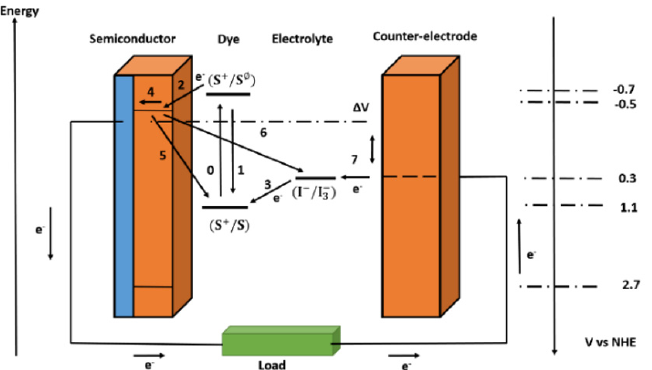
Figure 2. Simple energy level diagram for a DSSC. The basic electron transfer processes are indicated by numbers (1–7). by numbers